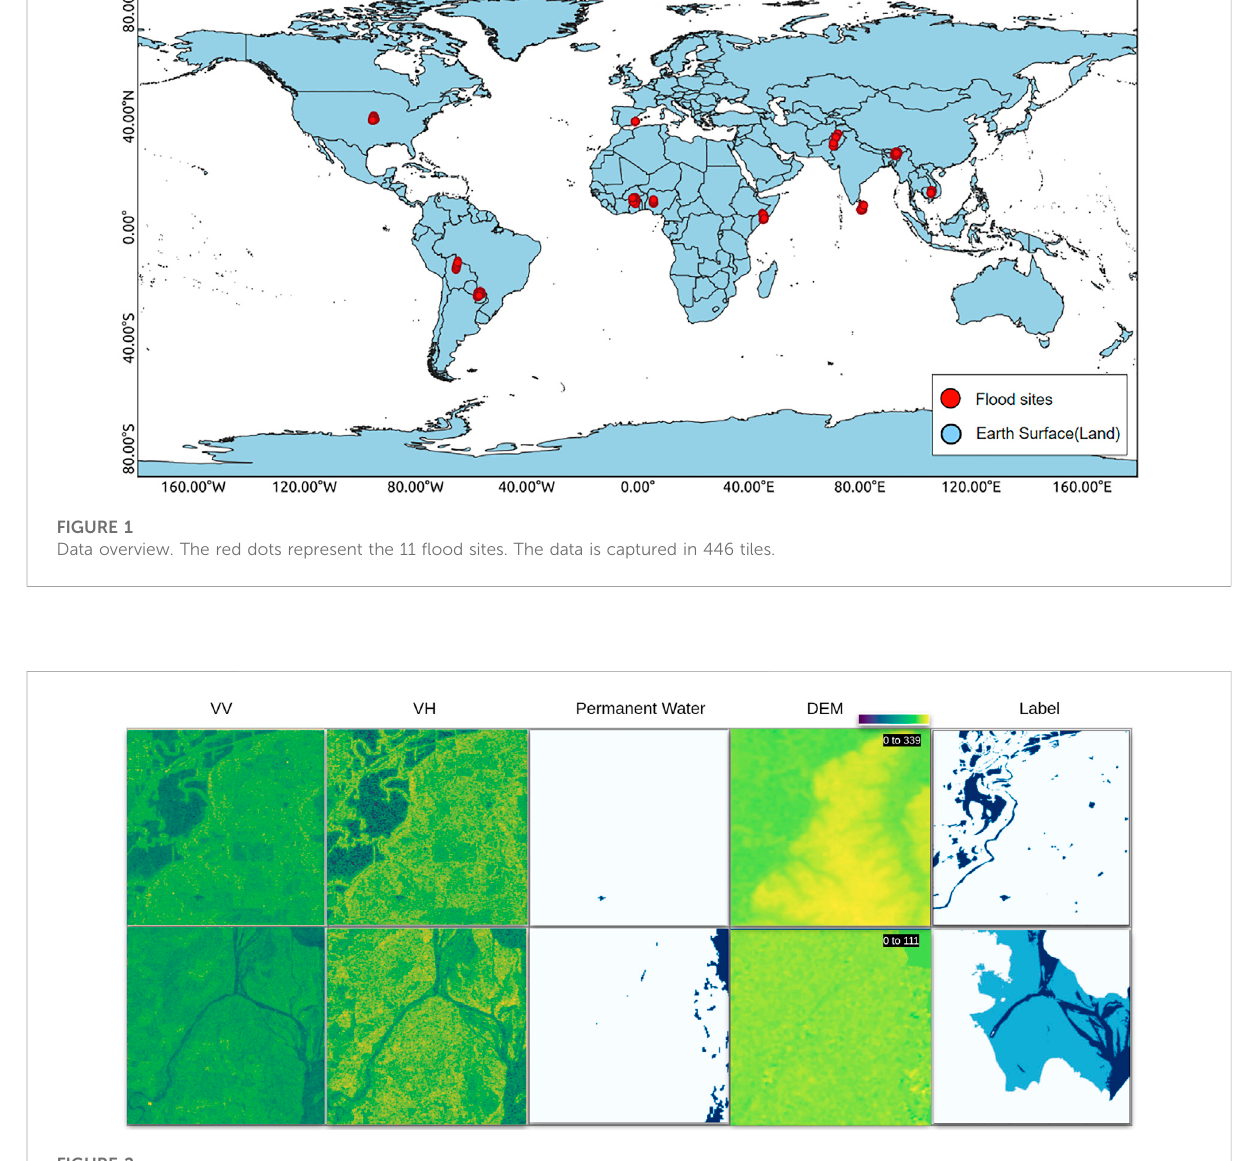
FIGURE 2 Sen1Floods11 data sample images. From left to right, VV, VH single channel SAR images, Permanent Water, Digital Elevation Model (DEM) and groundtrutharevisualized.ElevationrangeofeachsampleisshownintoprightcorneroftheDEMvisualization.The fi rstrowhas0,1andsecondrow has − 1, 0, 1 label values. The colors used for the values − 1, 0, 1 are white, sky blue, and dark blue,